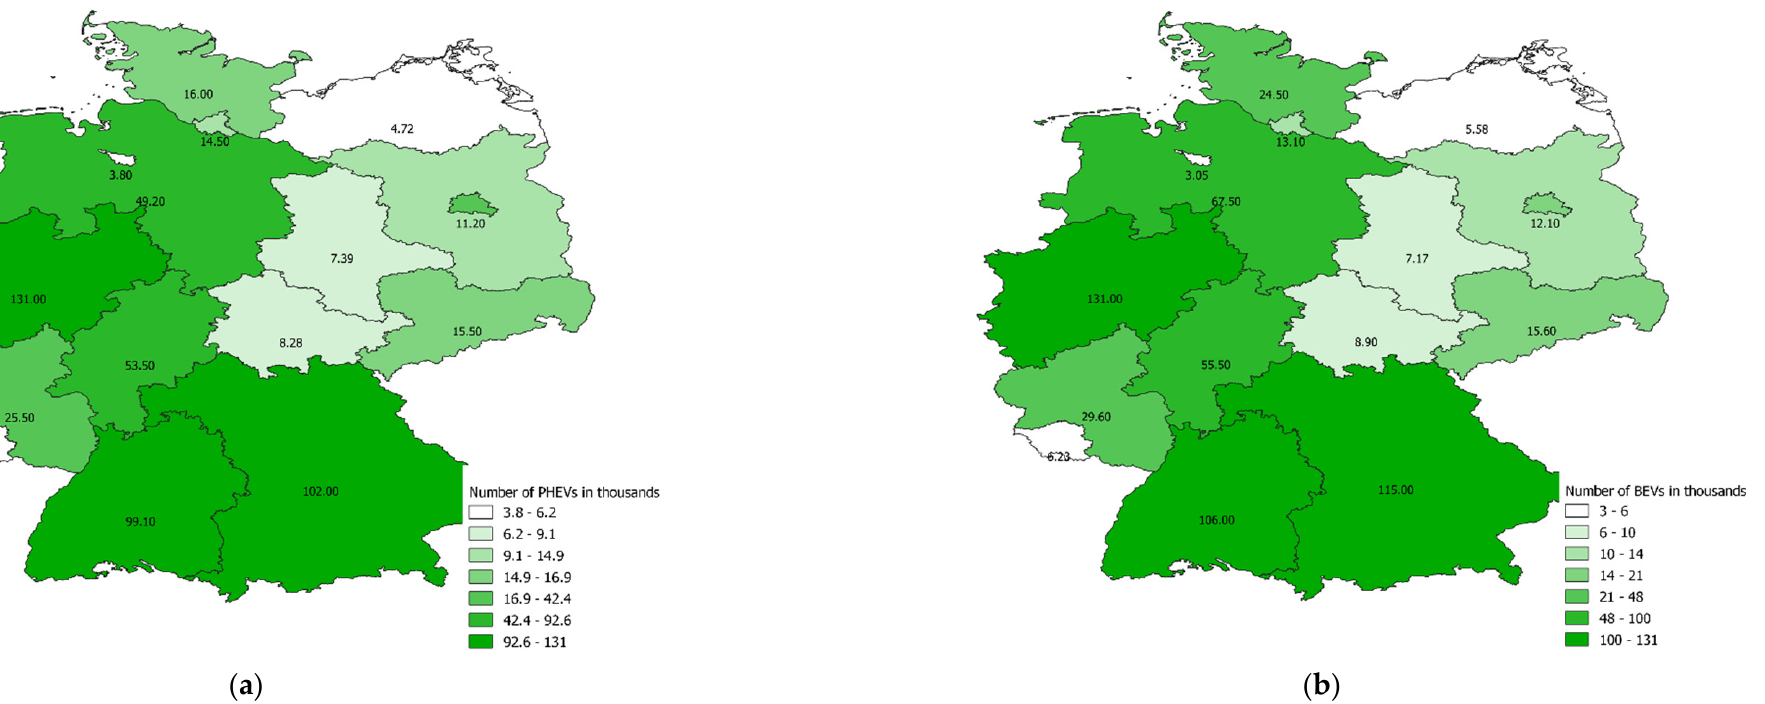
Figure A1. Visualization of where and how many vehicles by state on 1 January 2022 for ( a ) PHEVs and ( b ) BEVs. Values for Berlin are not shown for visual clarity (17.5 in ( a ) and 16.7 in ( b )). Note that there is no compensation for the fact that larger and more populous states are naturally likely to host more electric vehicles.